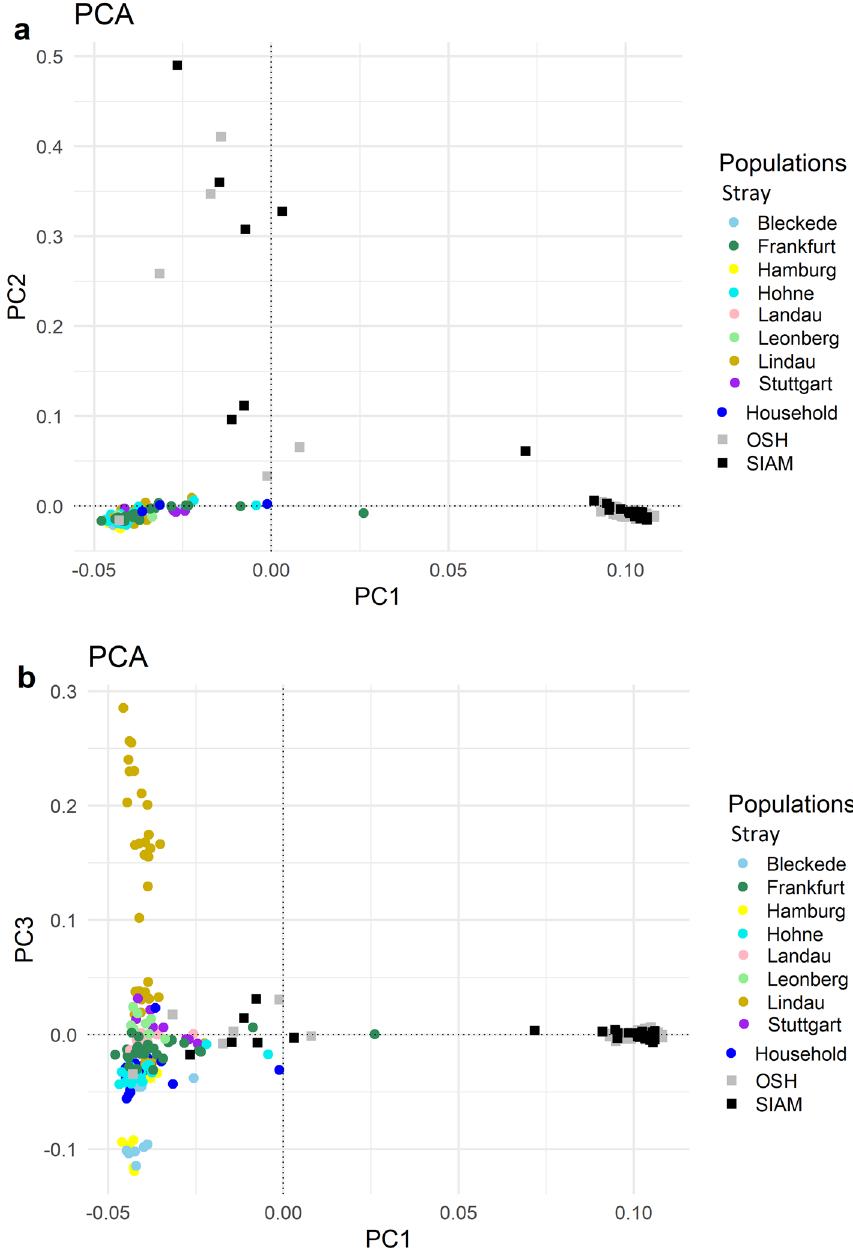
Figure 3. Principal component analysis of cat populations. Distances between cat populations are plotted in two dimensions for PC1 vs. PC2 in ( a ), PC1 vs. PC3 in ( b ). Non-breeding cats are highlighted by colored dots, each colored dot corresponding to a household population or a subpopulation of stray living in different regions of Germany (Bleckede, Frankfurt, Hamburg, Hohne, Landau, Leonberg, Lindau and Stuttgart). The black and grey squares represent the SIAM and OSH